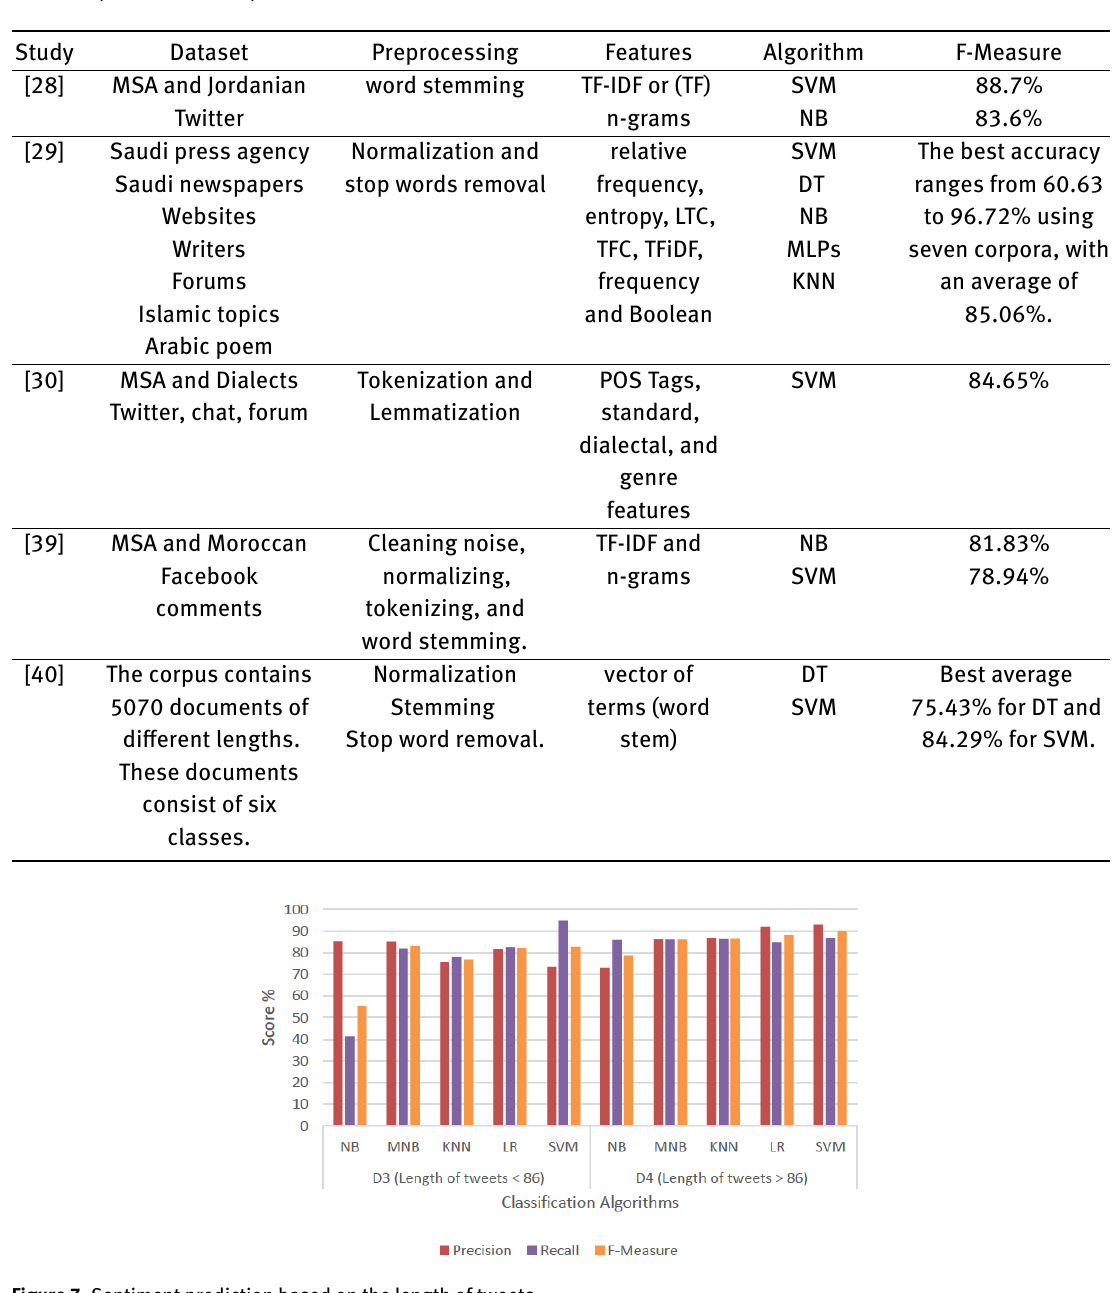
Table 7: A performance comparison of Arabic SA.